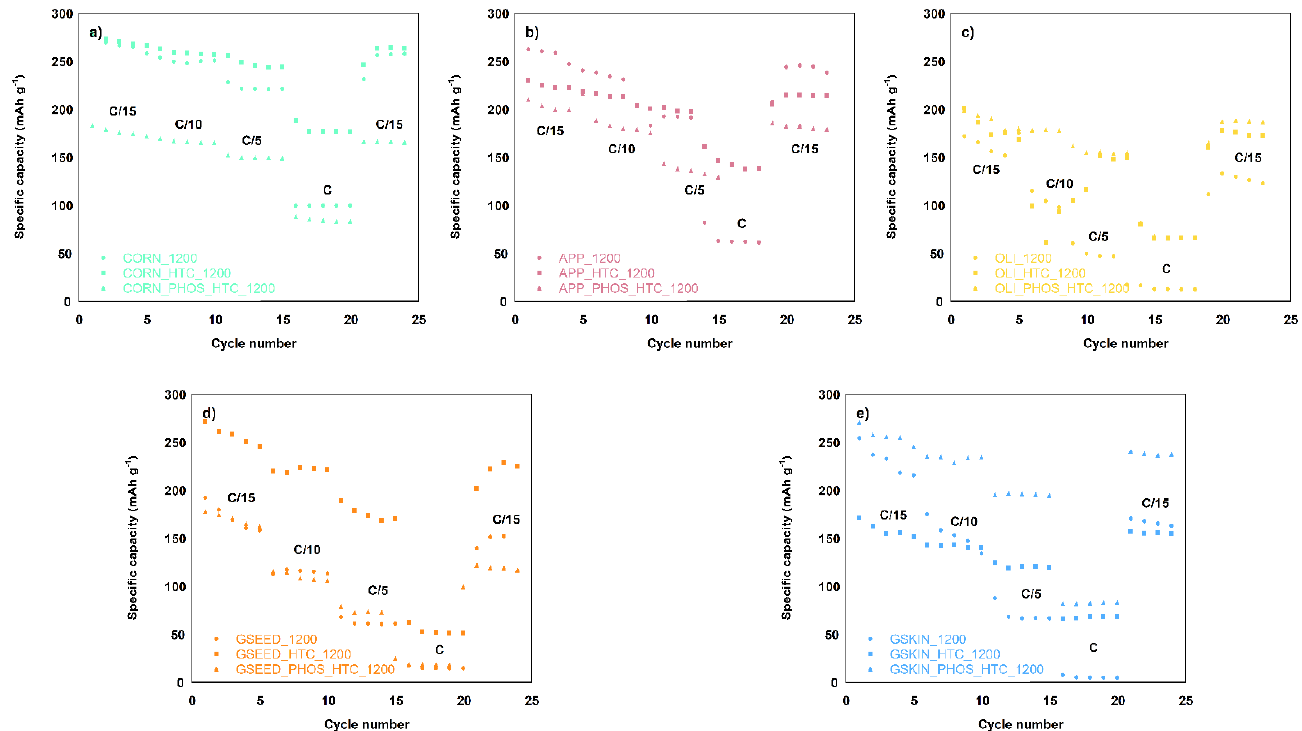
Figure 7. Discharge rate capability of corncob ( a ), apple pomace ( b ), olive mill solid waste ( c ), defatted grape seed ( d ) and dried grape skin ( e ) samples.